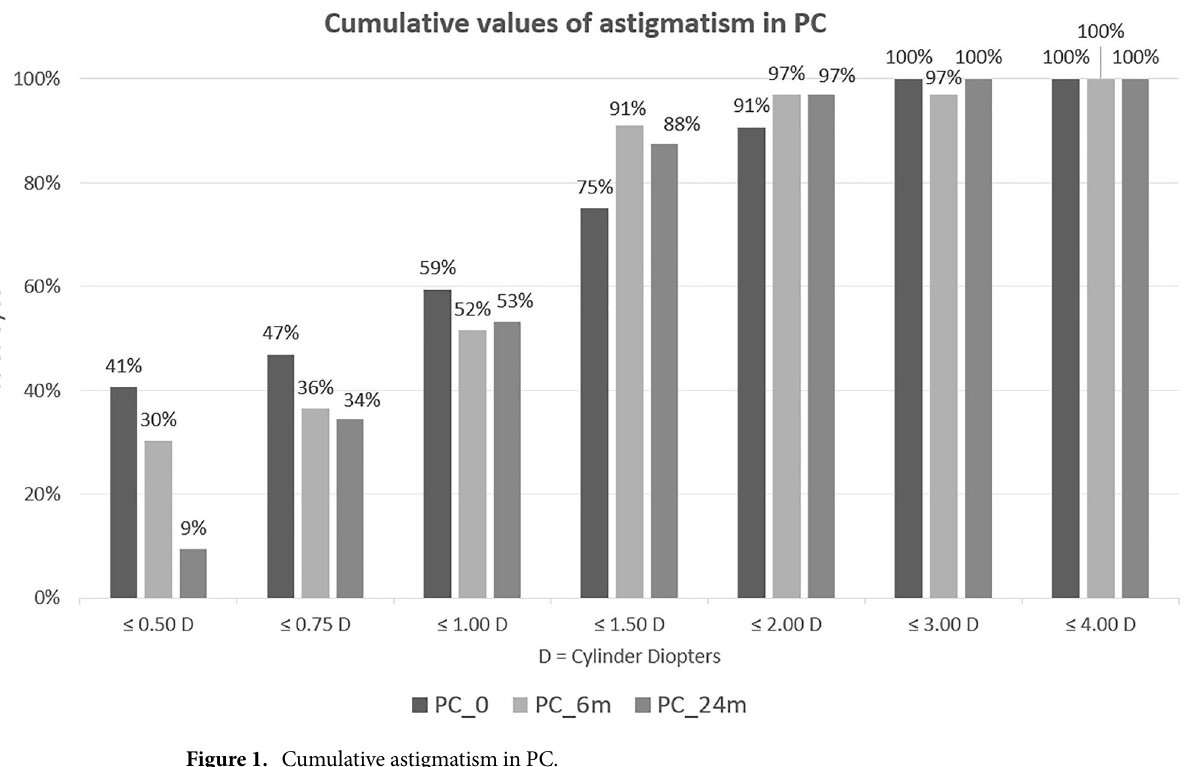
Figure 1. Cumulative astigmatism in